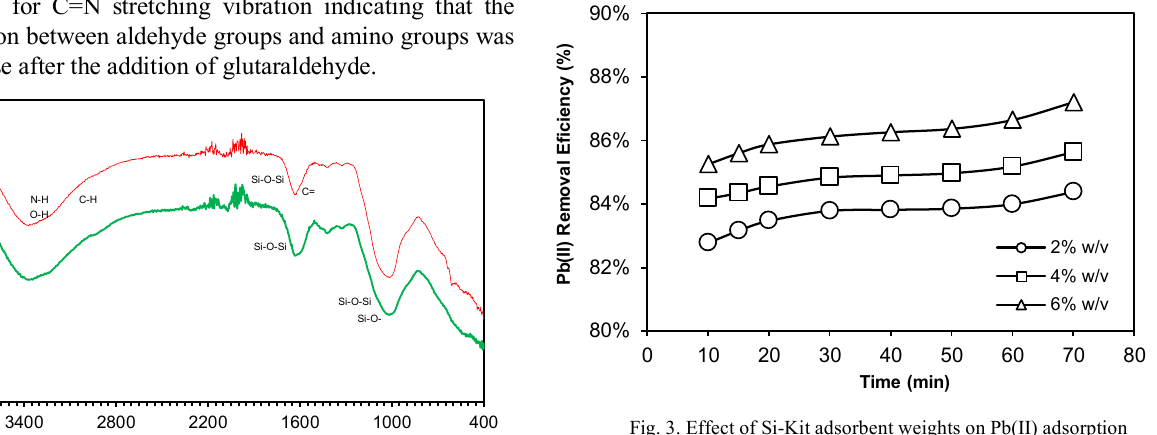
Fig. 3. Effect of Si-Kit adsorbent weights on Pb(II)